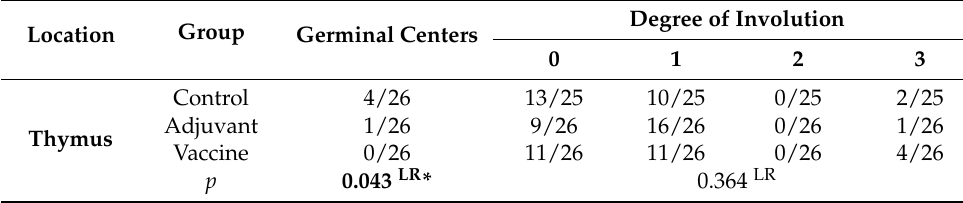
Table A21. Histopathological findings in the